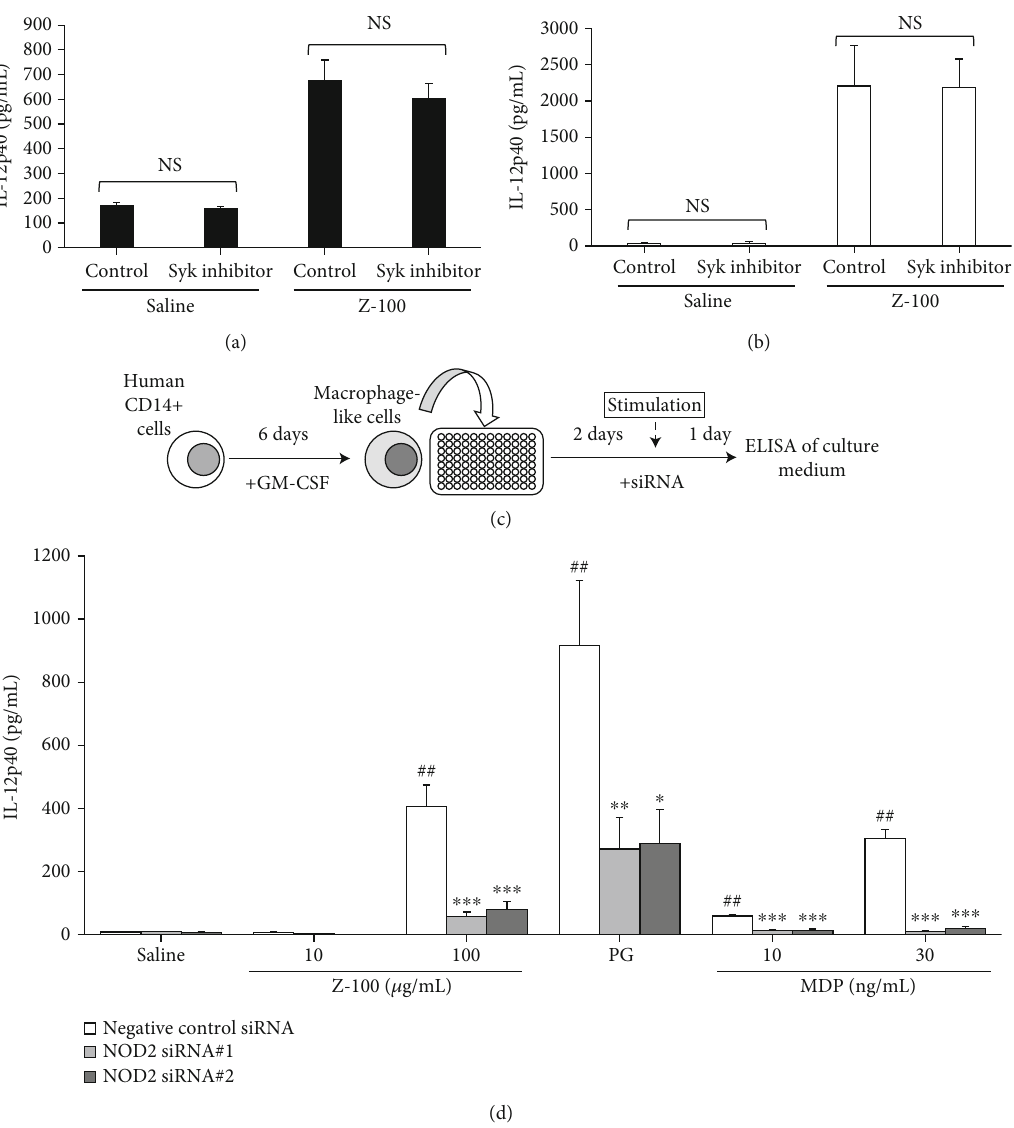
Figure 5: NOD2-mediated e ff ect of Z-100 on IL-12p40. (a) IL-12p40 concentration in the BMDM culture supernatant in the presence of Z-100 (100 μ g/mL) and a Syk inhibitor (100nM). Data show the mean ± S : E : ; n = 12 per group, pooled from 3 experiments. Statistical analysis was performed using Student ’ s t -test (vs. control; NS: not signi fi cant). (b) IL-12p40 concentration in the human CD14 + cell culture supernatant in the presence of Z-100 (100 μ g/mL) and a Syk inhibitor (100nM). Data show the mean ± S : E : ; n = 7 per group, pooled from 2 experiments. Statistical analysis was performed using Student ’ s t -test (vs. control; NS: not signi fi cant). (c) Schematic of the knockdown experimental design. Human CD14 + cells were cultured with GM-CSF for 6 days before being seeded onto siRNA custom plates (NOD2 siRNA#1, NOD2siRNA#2, and negative control siRNA) and incubated for 48 hours. After 48 hours, stimulants were added to the medium, and the cells were cultured for 24 hours. (d) IL-12p40 concentration in the culture supernatant of human CD14 + cells with siRNAs. The cells were stimulated with Z-100 (10 or 100 μ g/mL), PG (2 μ g/mL), or MDP (10 or 30ng/mL). Data show the mean ± S : E : ; n = 9 per group, pooled from 3 experiments. ## P < 0 : 01 vs. saline treatment in the negative control siRNA transfection group (Steel ’ s multiple comparisons test). ∗ P < 0 : 05 , ∗∗ P < 0 : 01 , and ∗∗∗ P < 0 : 001 vs. negative control siRNA transfection in each stimulation condition (PG and MDP 10 ng/mL group; Dunnett ’ s multiple comparisons test, other groups; Steel ’ s multiple comparisons